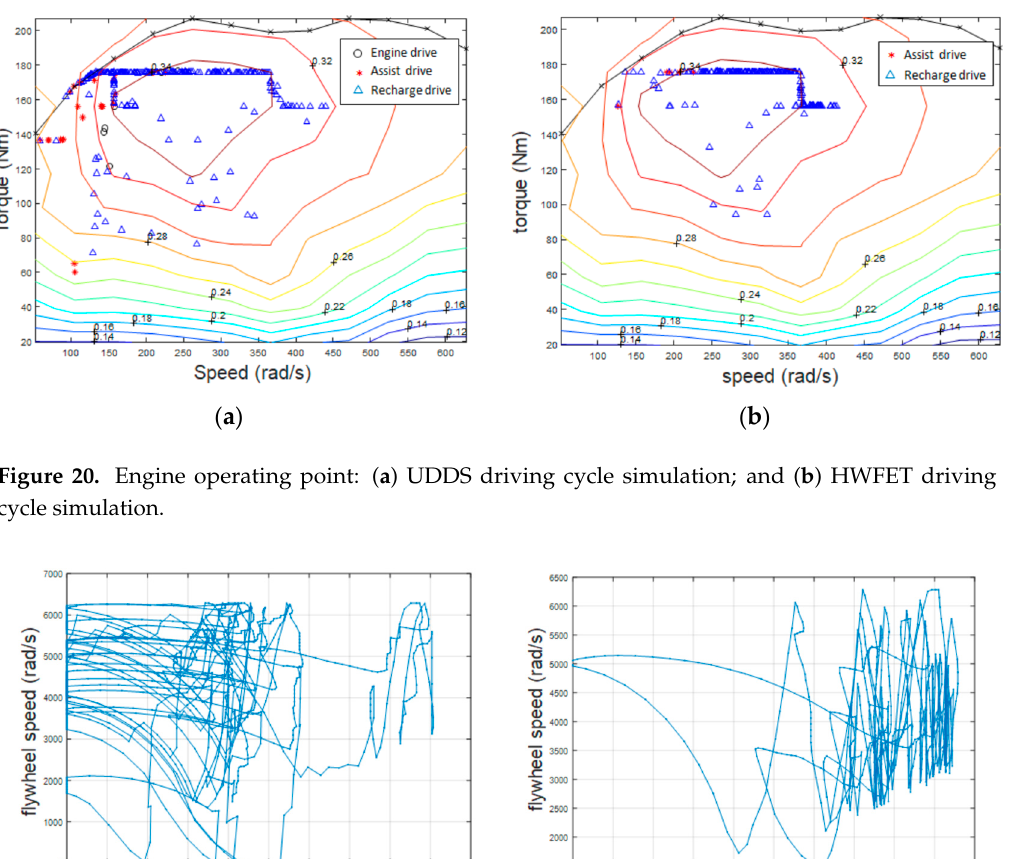
Table 3. Drive cycle simulation results.